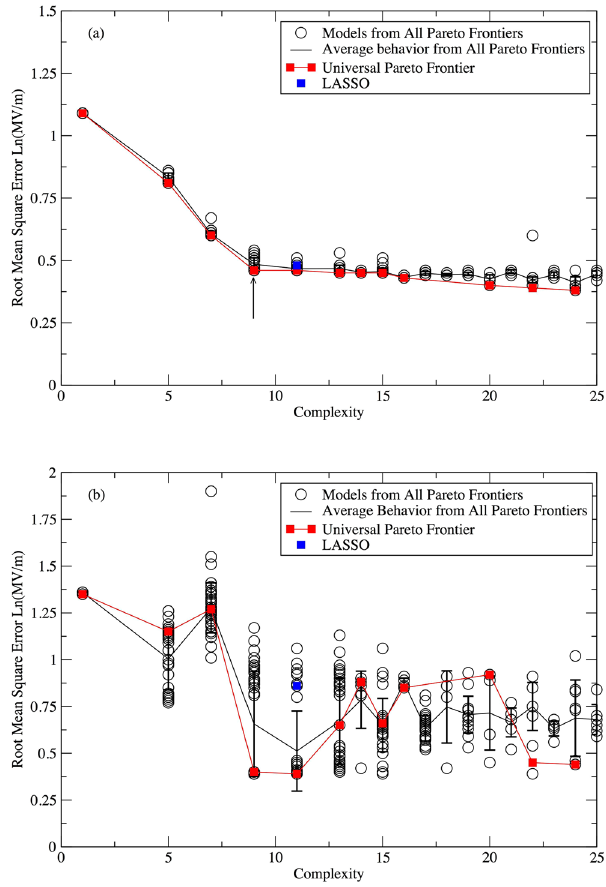
Figure 6. Comparison of RMSE performance of models on ( a ) training + validation and ( b ) test data between LASSO, the universal Pareto frontier and models from all Pareto frontiers. The arrow in ( a ) indicates the point at which there is a relatively large change in the slope along the Pareto frontier.